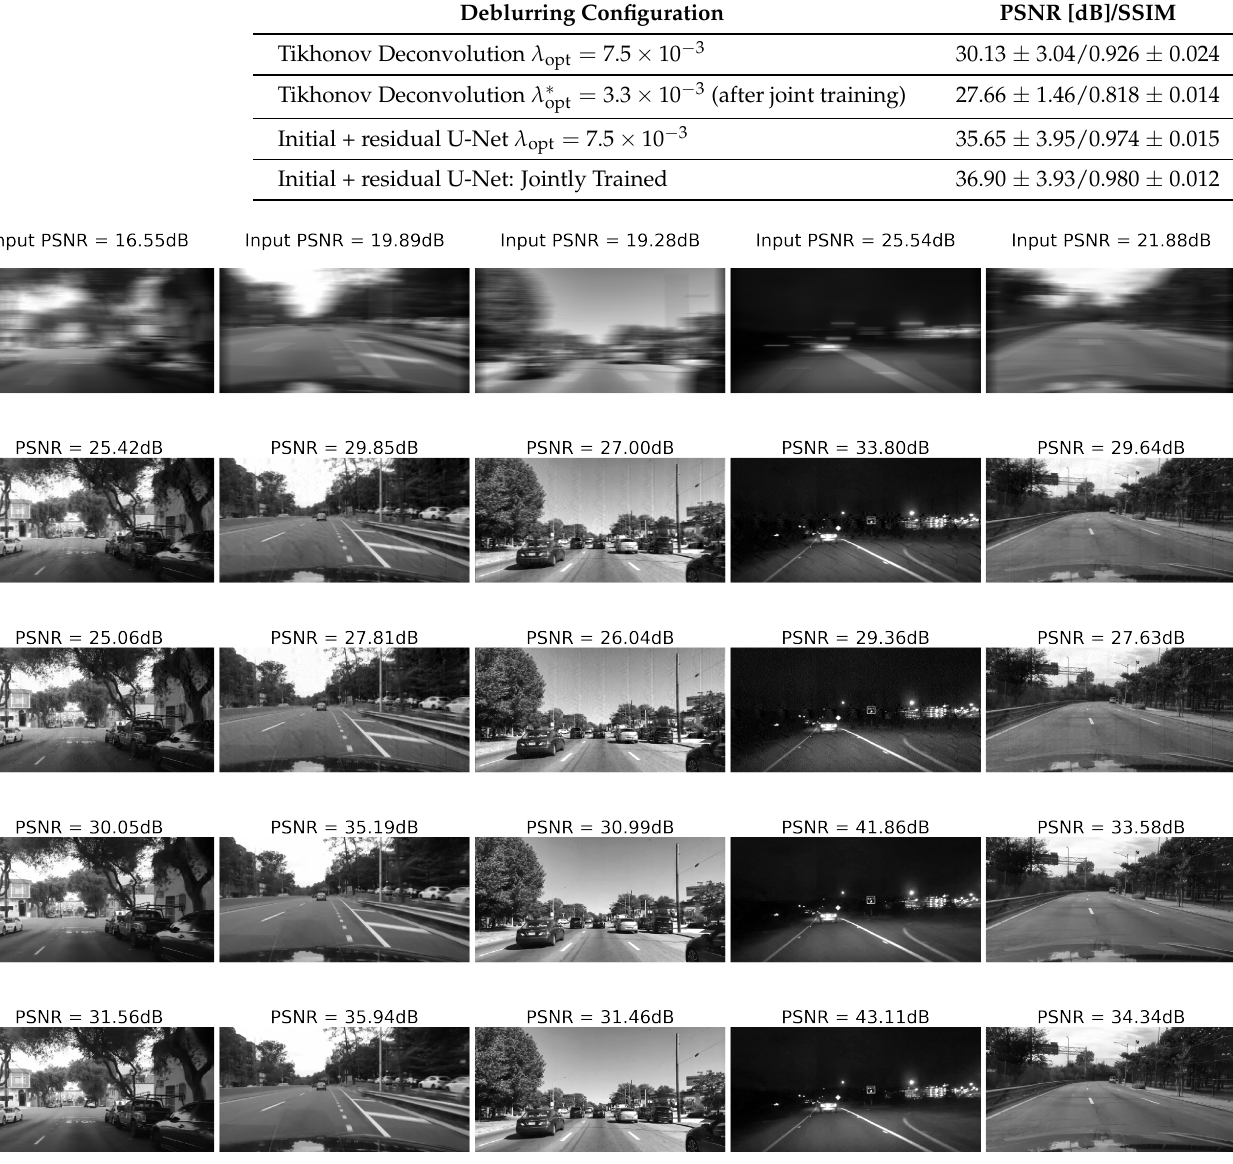
Table 2. Typical deblur quality before and after joint optimization.